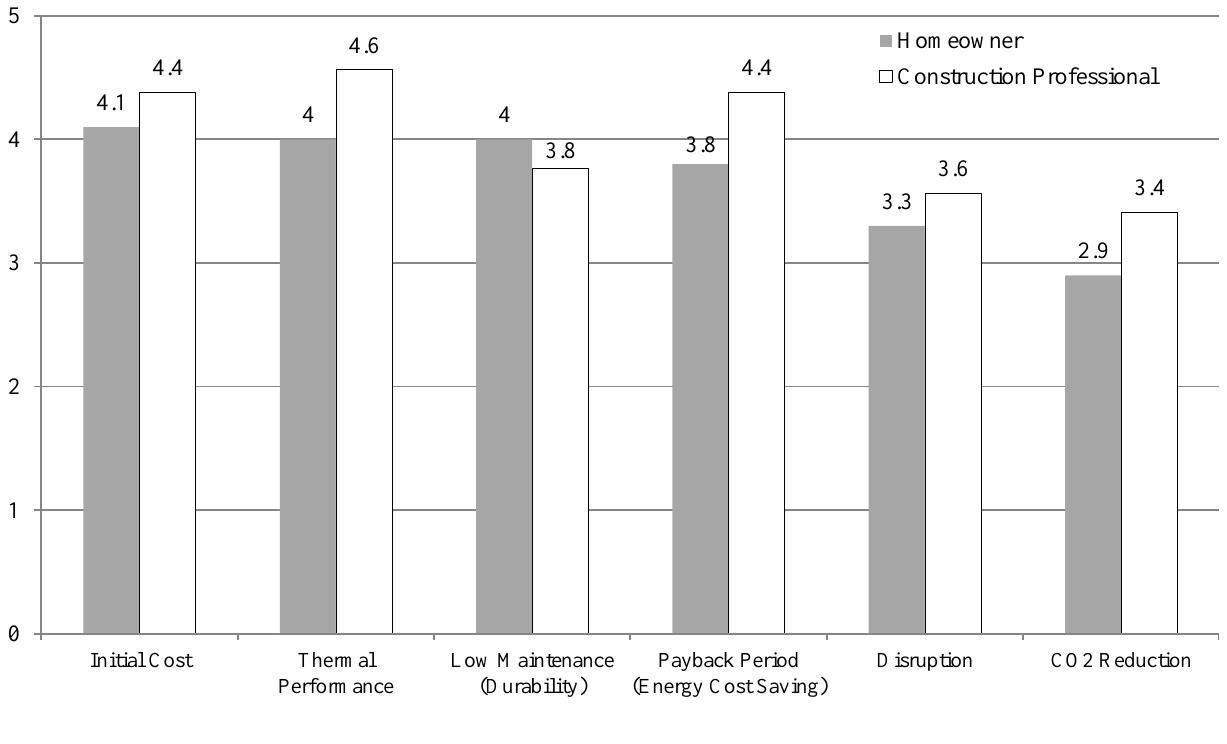
Figure 3. Decision making factor for refurbishment measure (Likert scale from 5—“Very Important” to 1—“Not